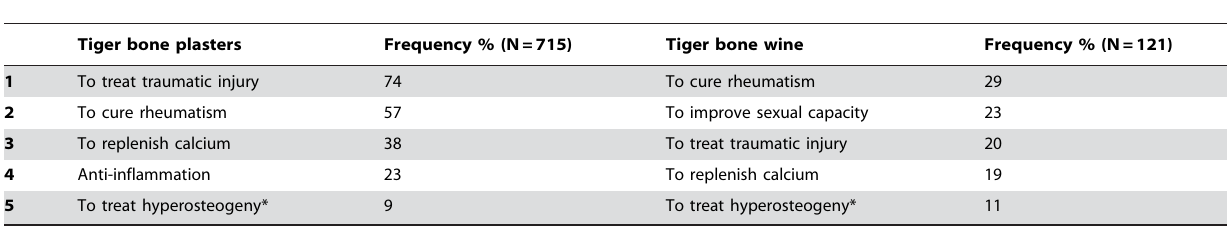
Table 1. The top 5 reasons cited for using tiger bone